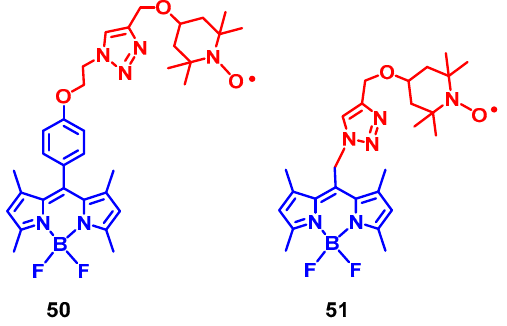
Figure 16. TEMPO-Bodipy dyads as radical-chromophore heavy atom-free triplet PSs. Both dyads show strong absorption of visible light. 50 shows non-efficient ISC ( Φ ∆ = 14%), and longer triplet-state lifetime ( τ T = 190 µ s) than 51 ( Φ ∆ = 56%